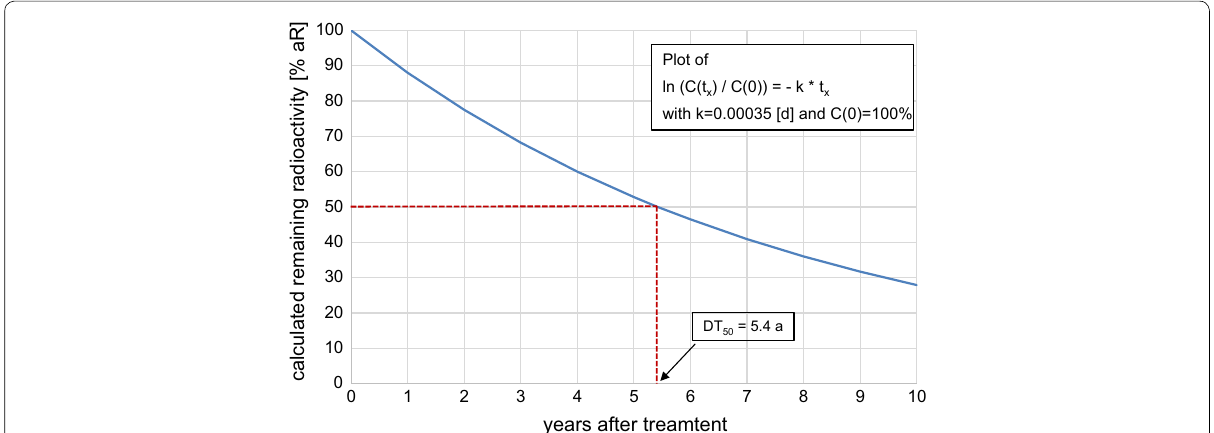
Fig. 10 Projected decrease of remaining radioactivity (% aR) in the 10 cm top layer within 10 years after